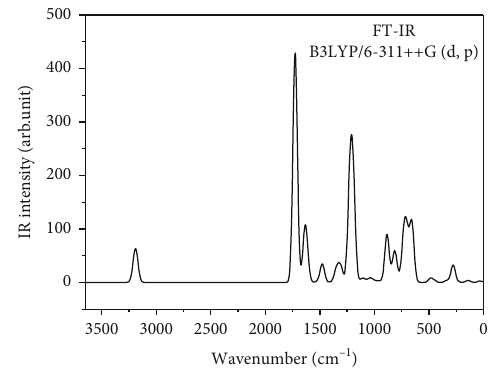
Figure 2: Computed FT-IR spectrum of benzil.